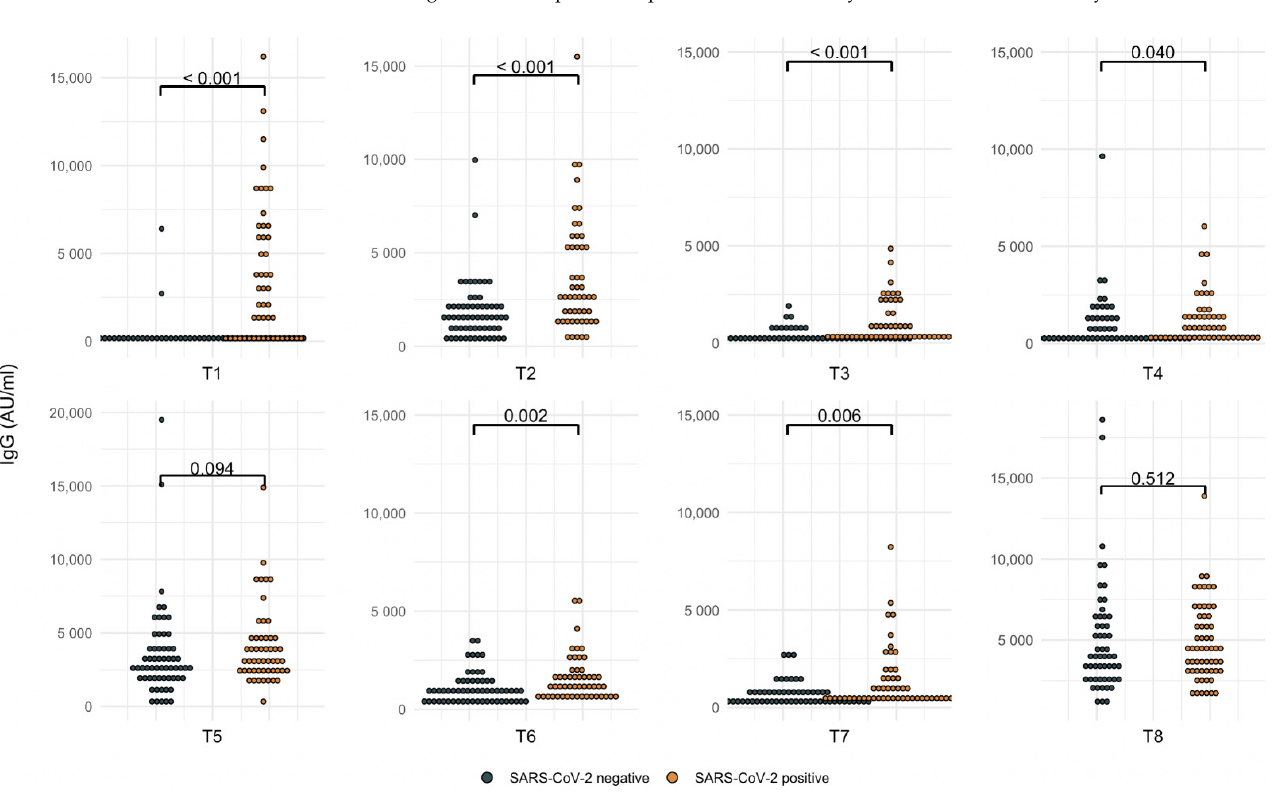
Figure 1. Anti-S1-S2 IgG antibody titers according to SARS-CoV-2 infection history. Figure 1 shows the cumulative cases according to positive or negative SARS-CoV-2 infection, n = 112. T1: 21–28 days after the first BNT162b2 dose (SARS-CoV-2 positive = 49). T2: 21–28 days after the second dose (SARS-CoV-2 positive = 50). T3: 3 months after the second dose (SARS-CoV-2 positive = 50). T4: 1–7 days after the third dose (SARS-CoV-